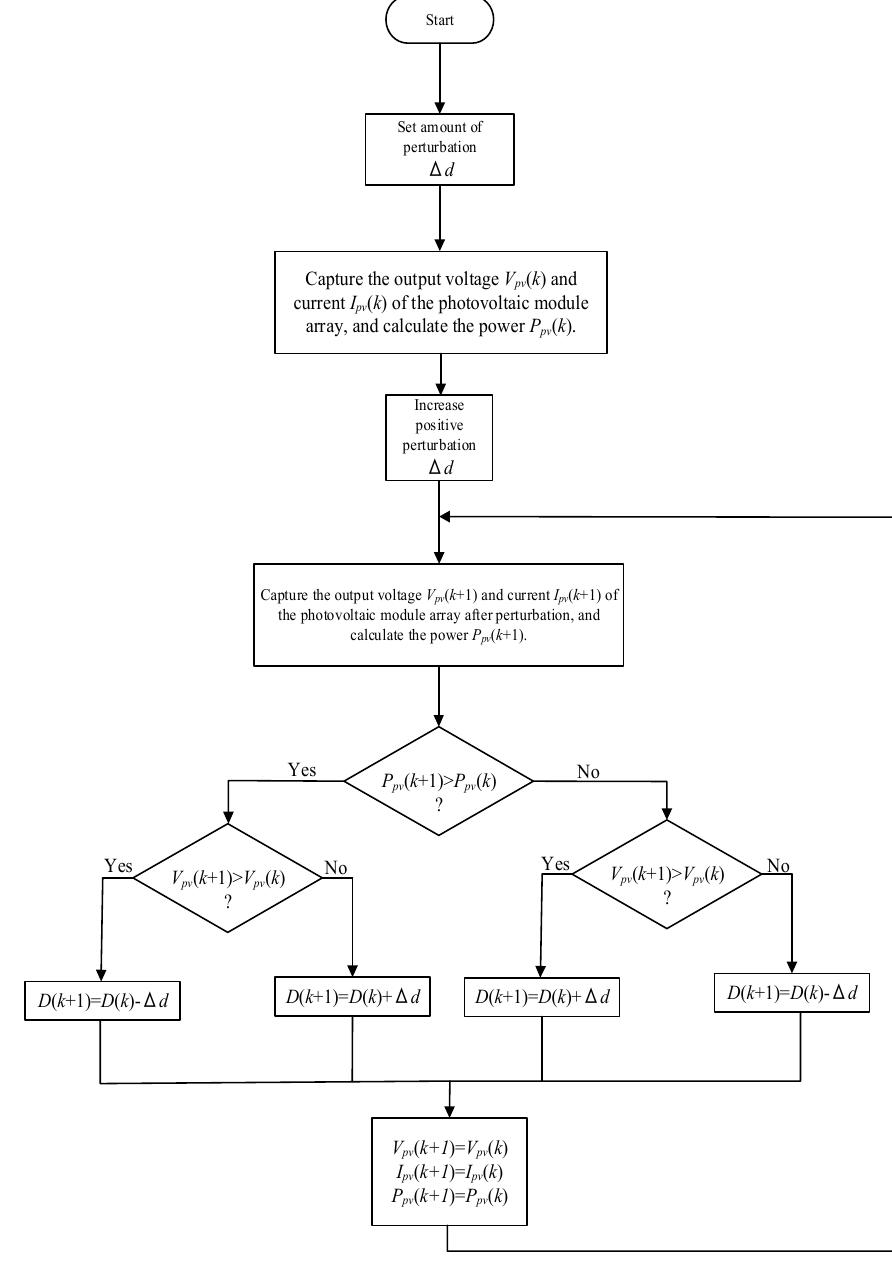
Figure 2. Process for the perturb and observe MPPT method.